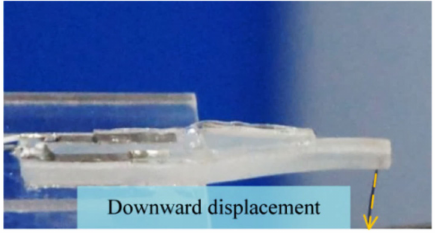
Figure 10. Photo of displacement applied to the tactile